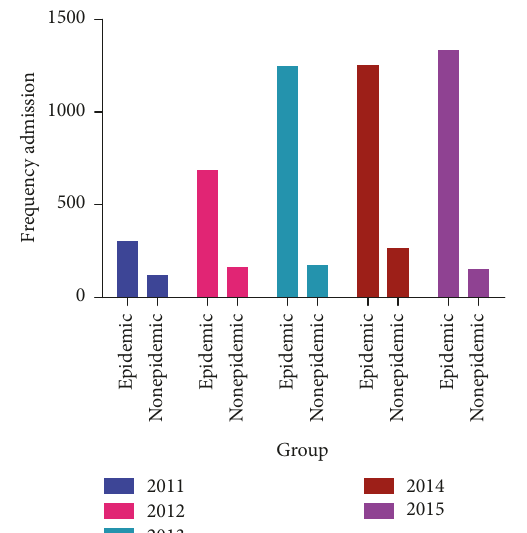
Figure 2: Frequency distribution of number of admissions during the epidemic and nonepidemic periods in the five years of study.